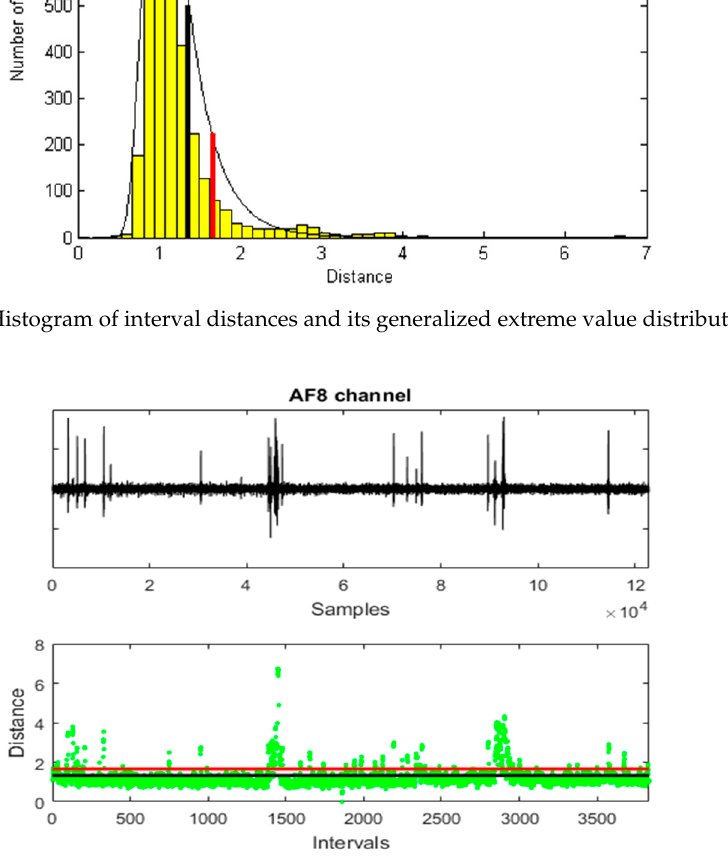
Figure 4. An EEG channel, the distances of the intervals to their centroid and the thresholds T 1 (in black) and T 2 (in red).